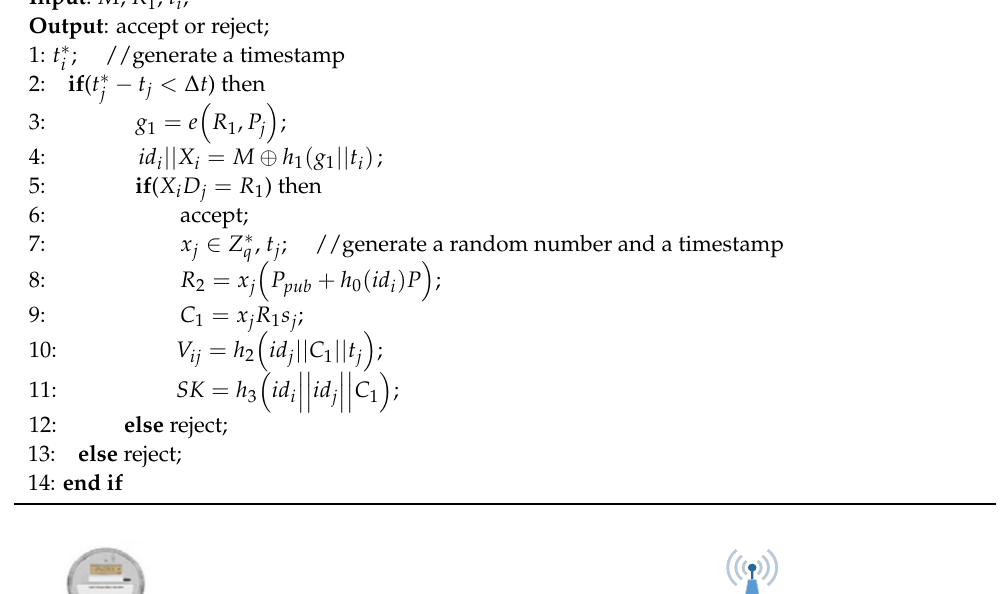
Algorithm 4. AG j authenticates SM i